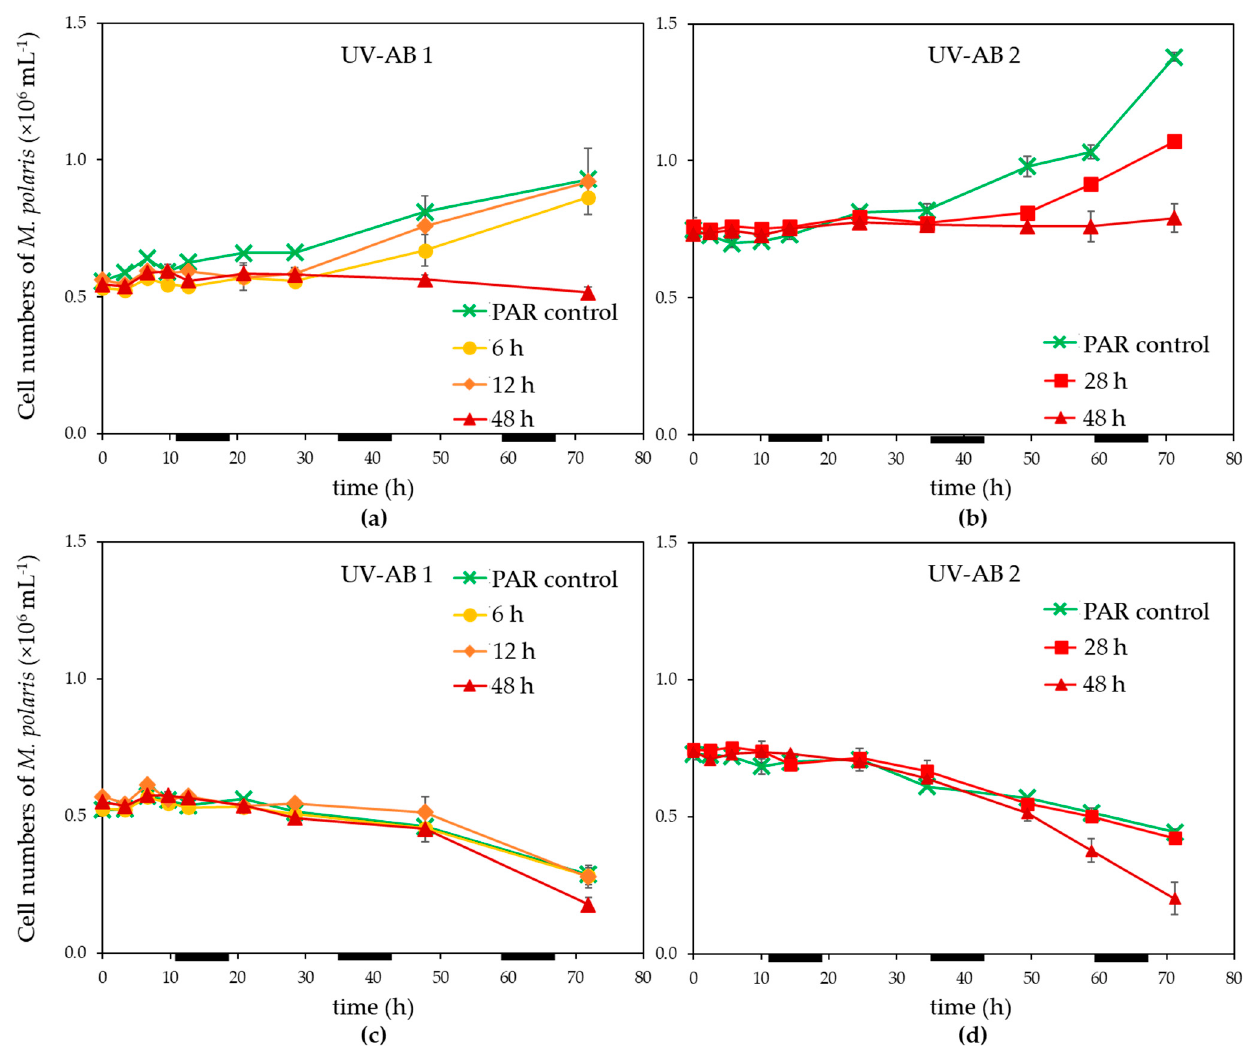
Figure 1. Temporal dynamics of ( a , b ) non-infected controls, ( c , d ) infected Micromonas polaris abundance under PAR + UV-AB exposure (6, 12, 28 and 48 h, over 72 h experimental duration) compared with PAR-only controls for ( a , c ) experiment 1 and ( b , d ) for experiment 2. Average values with standard deviation ( n = 2, except for experiment 2 PAR-only control where n = 1). Light–dark cycle was 16:8 h, during dark periods UV exposure was stopped. The horizontal black bars indicate the dark period.